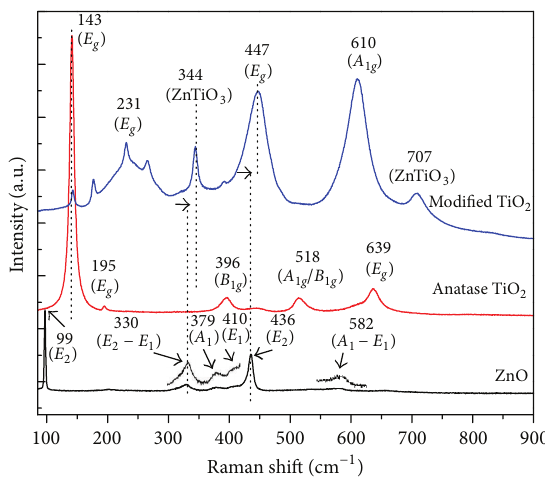
Figure 1: Raman spectrum of ZnO, anatase, and hybrid ZnO/TiO 2